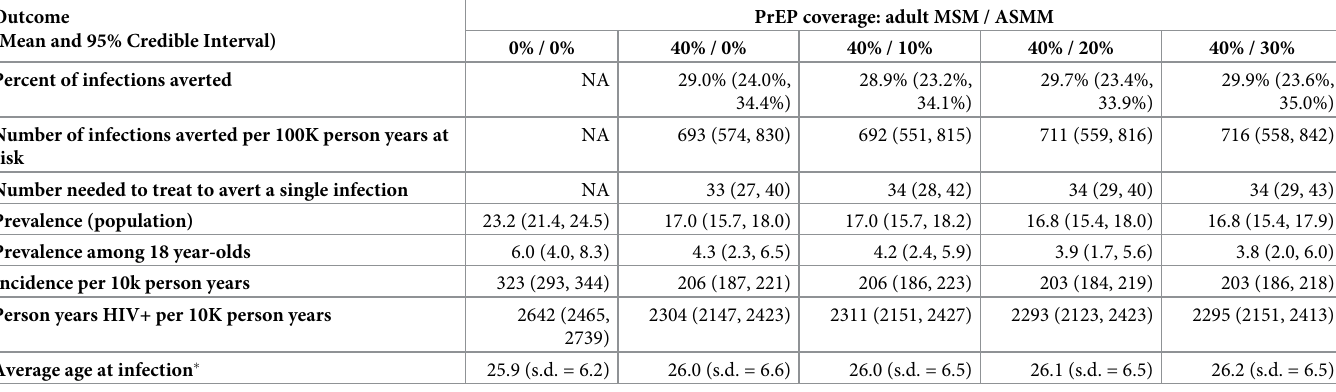
Table 1. The percentage of infection averted, the number of infections averted per 100K person years at risk, the number needed to treat to avert a single infection, prevalence, incidence, person-years HIV positive, and age at infection over 10 years of a PrEP intervention for adult men who have sex with men (MSM) and adoles- cent sexual minority males (ASMM).